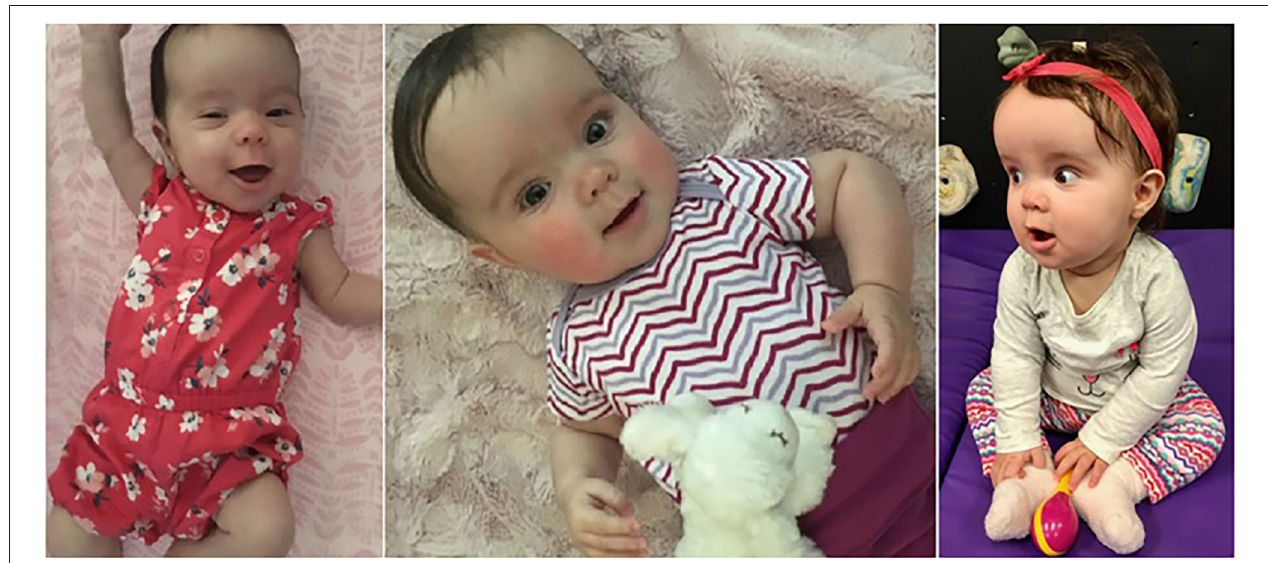
FIGURE 3 | A patient diagnosed with phosphatase and tensin homolog (PTEN)-hamartoma tumor syndrome. She was brought to medical attention shortly after birth for concerns of macrocephaly and hypotonia. Her brain MRI was normal. At 14 months, her fronto-occipital circumference (FOC) was 52.6cm ( + 5.38 SD) and 56.4cm ( + 5.06 SD) at 35 months. She has been receiving physical therapy since age 6 months due to hypotonia and also speech therapy for expressive language delays. FOC > 3 SD even as isolated finding is suspicious of PTEN-hamartoma tumor syndrome. Due to the increased risk for malignancy (see text and Table 2 ), she will undergo childhood cancer screening (thyroid carcinoma) and later adult cancer screening (breast, thyroid, endometrial, and colon). Developmental delays are common in this